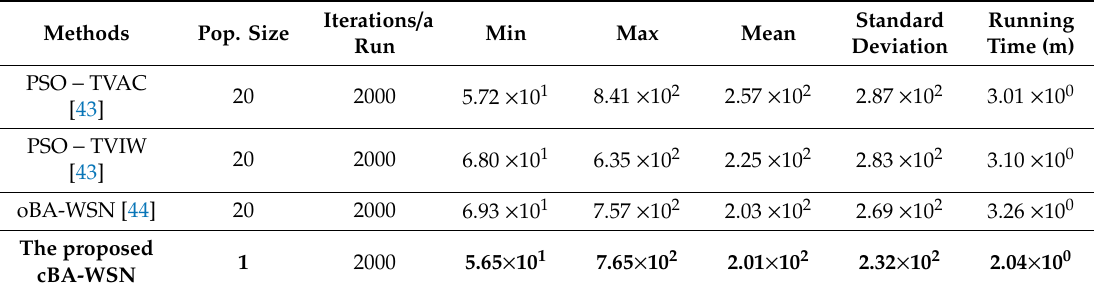
Table 7. The comparison of averaged outcomes and computation time of cBA-WSN with other methods,